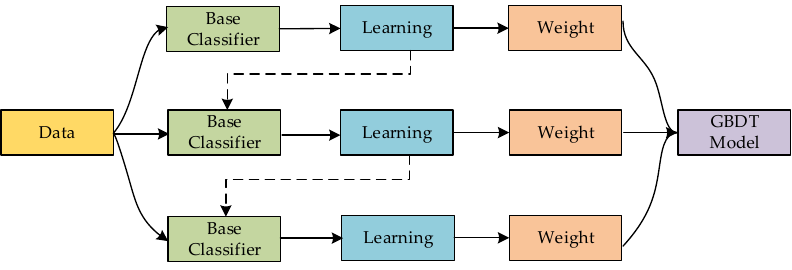
Figure 1. The process of training the gradient boosting decision tree